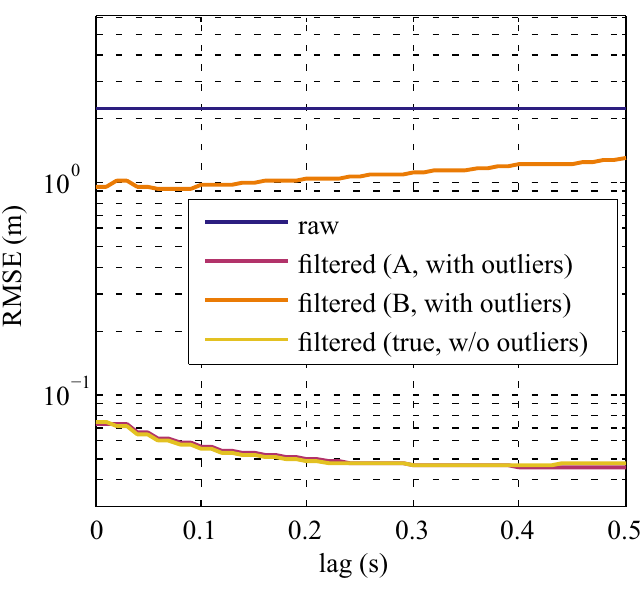
Figure 5. RMSE of Dataset D 2 (without training set). The results were obtained in analogy to those from Dataset D 1 , depicted in Figure